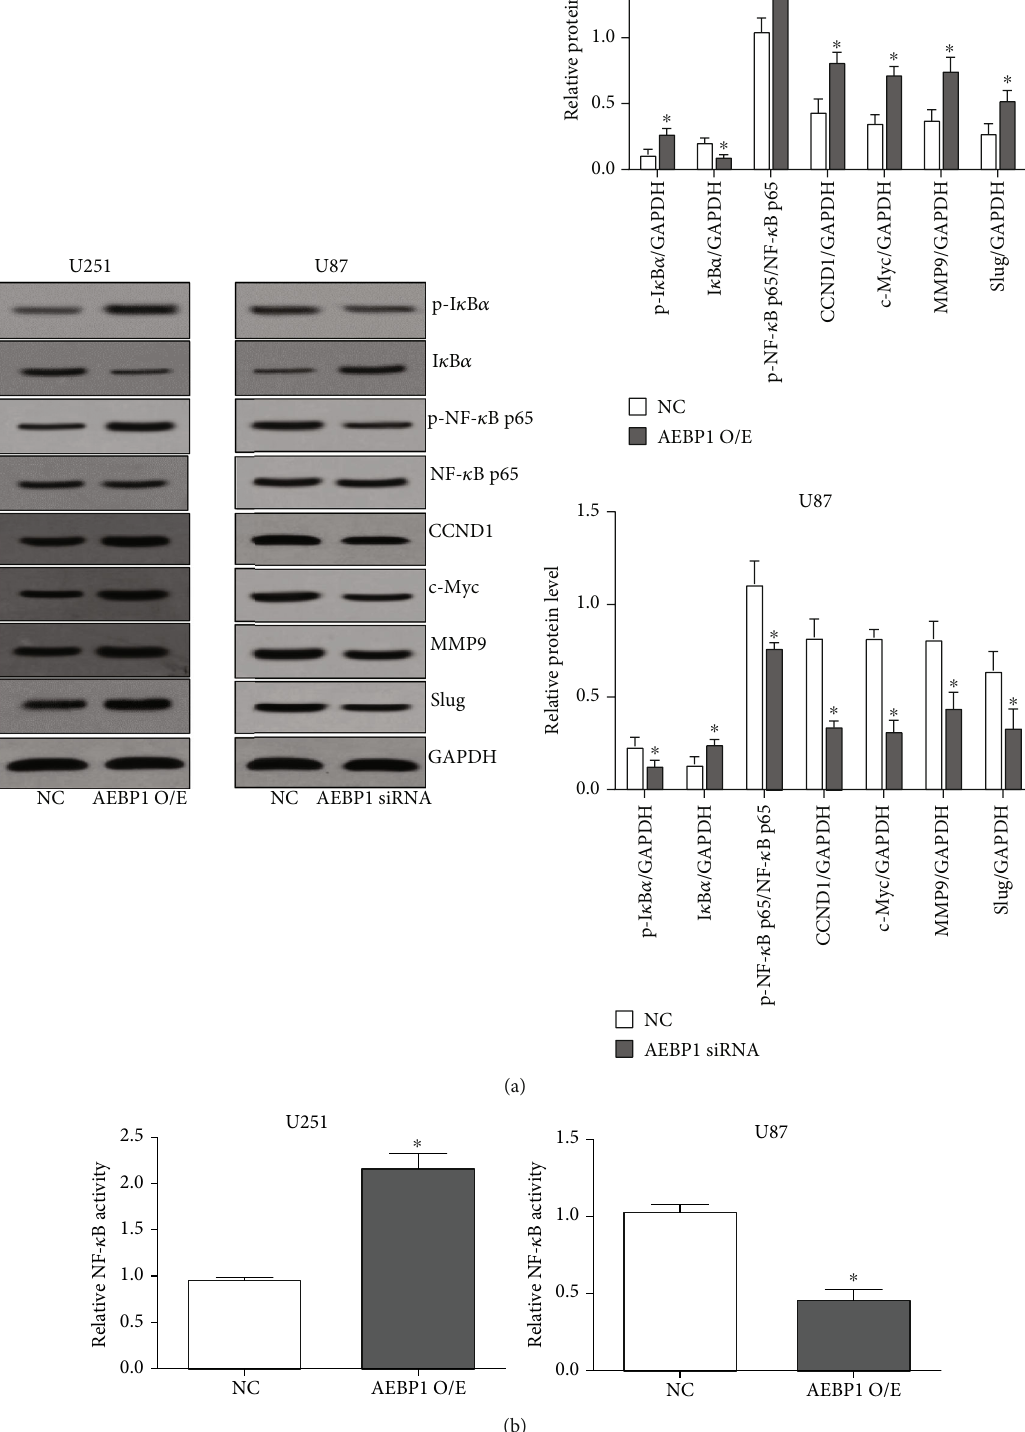
Figure 7: AEBP1 activated the NF- κ B signaling pathway in GBM cells: (a) the expression and phosphorylation levels of proteins related to the classical NF- κ B pathway were detected by western blot; (b) a luciferase reporter assay was used to assess the transcriptional activity of NF- κ B. N = 3 , ∗ P < 0 : 05